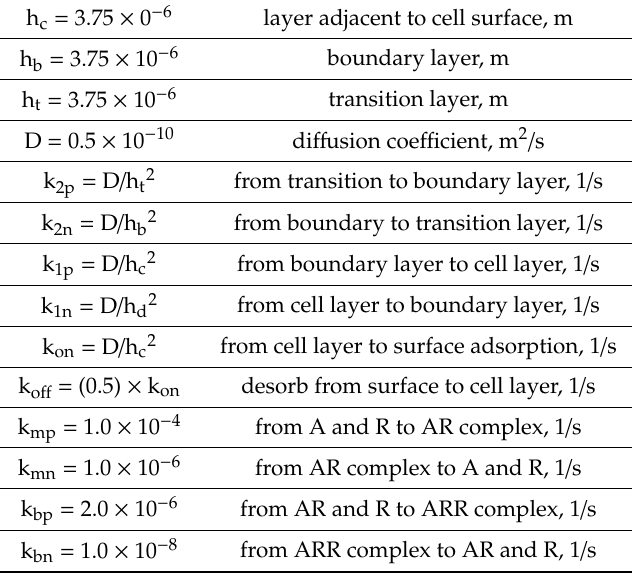
Table 1. Values of parameters and reaction rate constants used in the